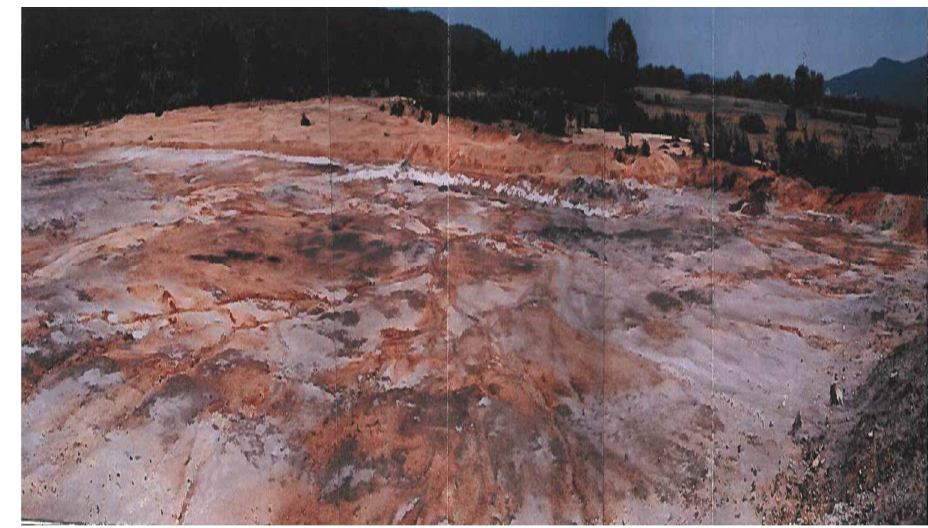
Figure 2. Old arsenopyrites concentrate storage area (former METBA plot).